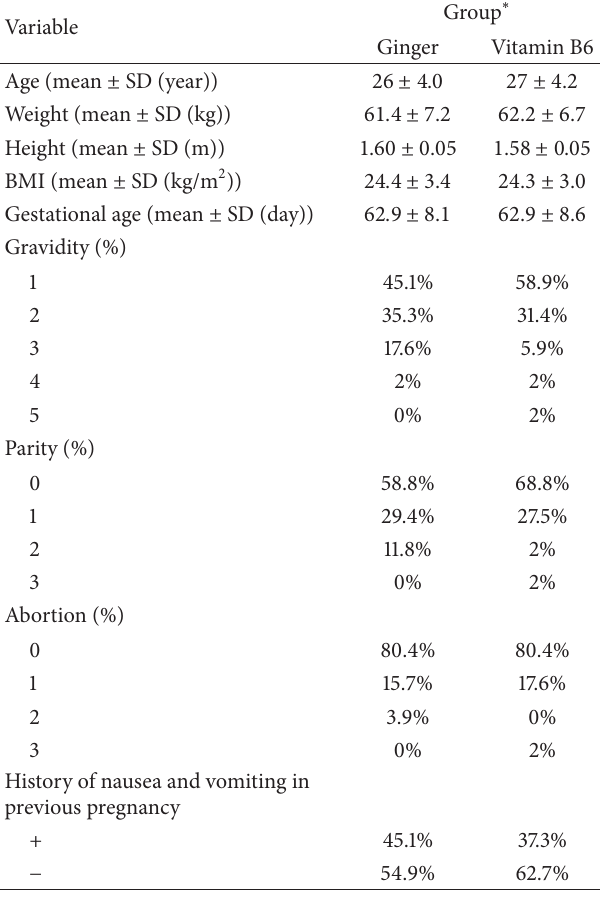
Table 1: Evaluation of characteristic variables between the two